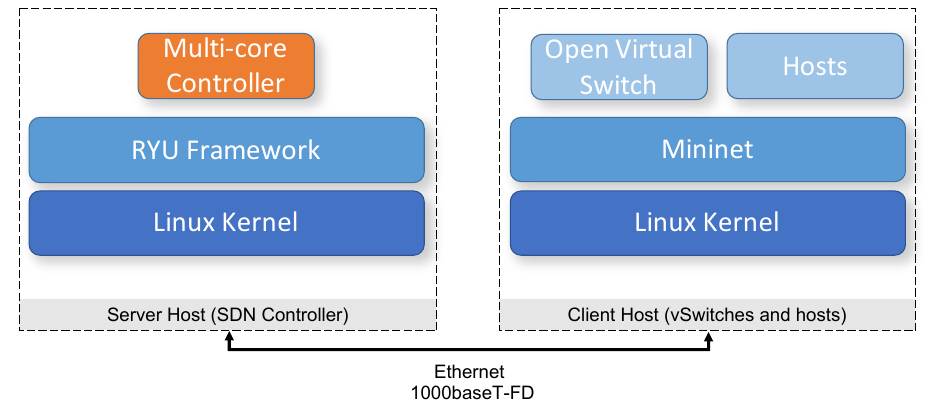
Figure 7. Block diagram of